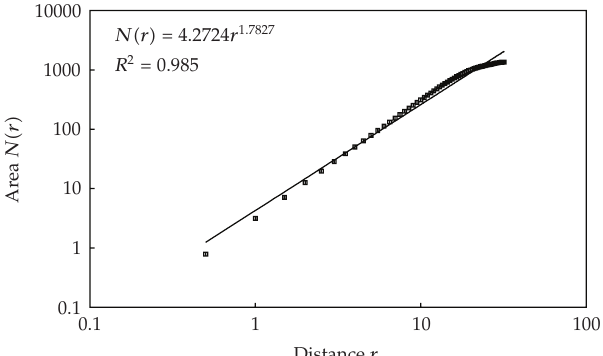
Figure 6: A log-log plot of the relation between radius and corresponding land use quantity of Beijing (cid:3) 2005 (cid:4) .